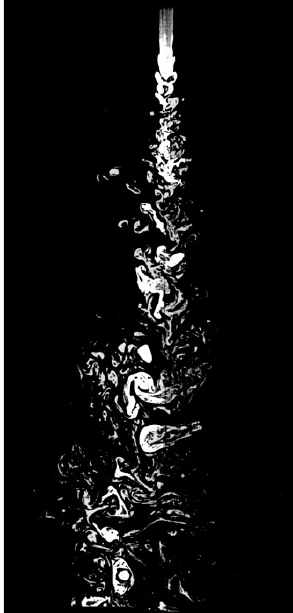
Figure 3: Turbulence as observed in a turbulent water jet (Van Dyke, 1982) reported in the book by Frisch (1995) (photograph by P. Dimotakis, R. Lye, and D.